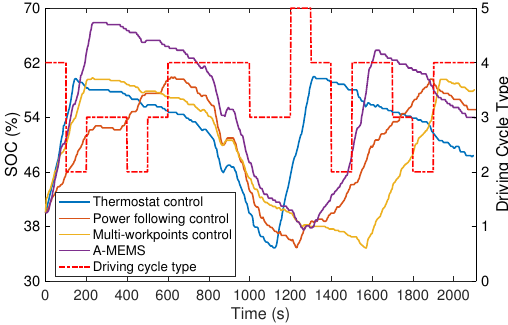
Figure 20. Battery SOC trajectory of different control